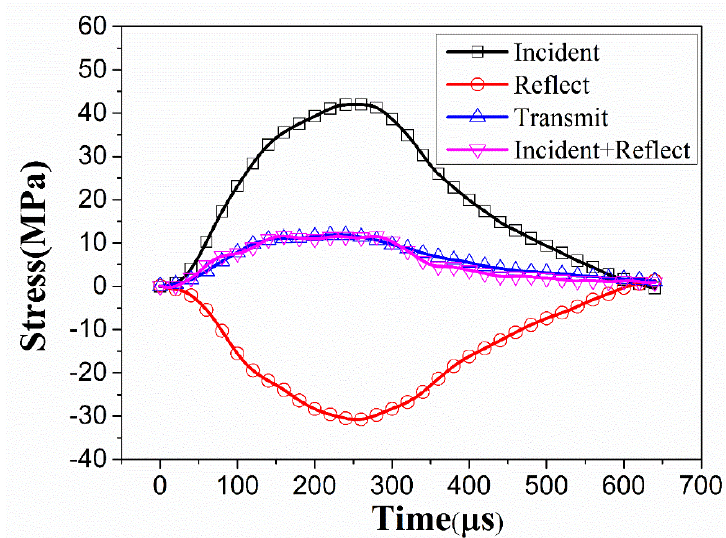
Figure 2. Stress equilibrium of typical concrete specimen.